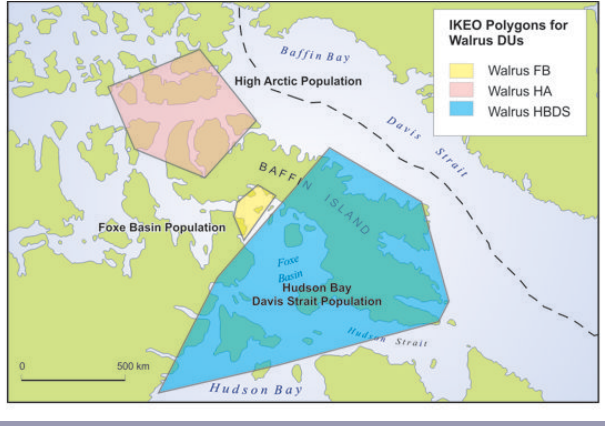
Fig. 6 . Inuit knowledge extent of occurrence (IKEO) polygons for walrus ( Odobenus rosmarus rosmarus ) designatable units (DUs). See Appendix 1 for glossary of